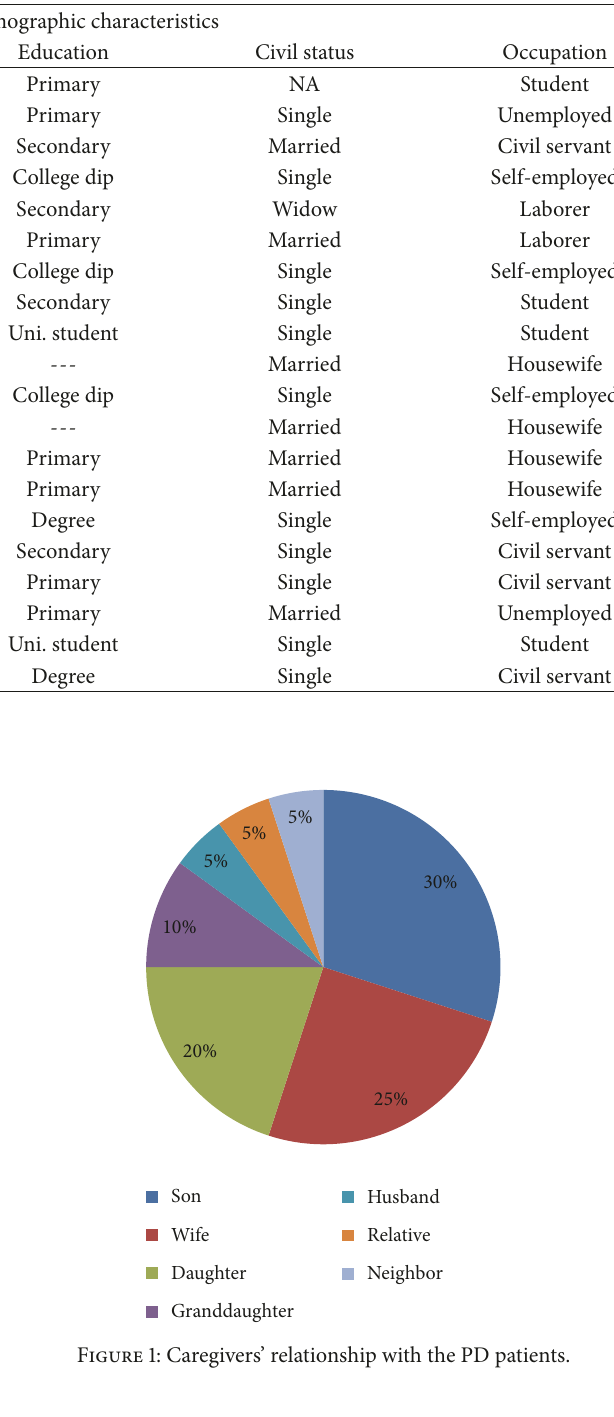
= 7.91). Vast majority (75%) of them were married. Almost all of the caregivers do not know the exact time when the illness of the PD patient under their care started the but in average it was about 5 years since the patients were diagnosed with